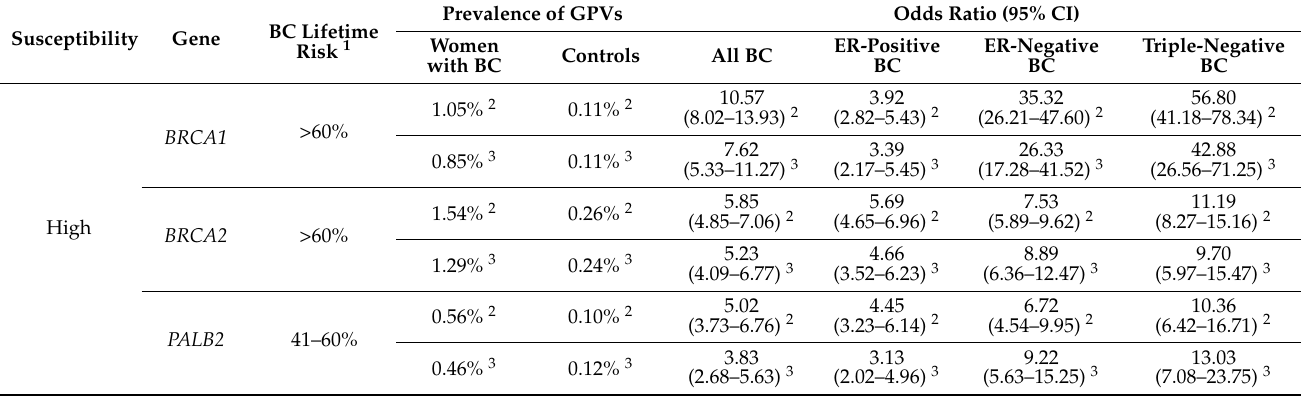
Table 1. Prevalence of GPVs of 12 BC predisposition genes in BC patients and control subjects.